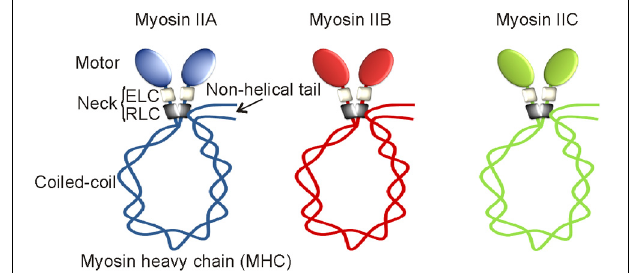
FIGURE 1 | Non-muscle myosin II motor proteins. Schematic representation of myosin II motor proteins that exist as complexes in